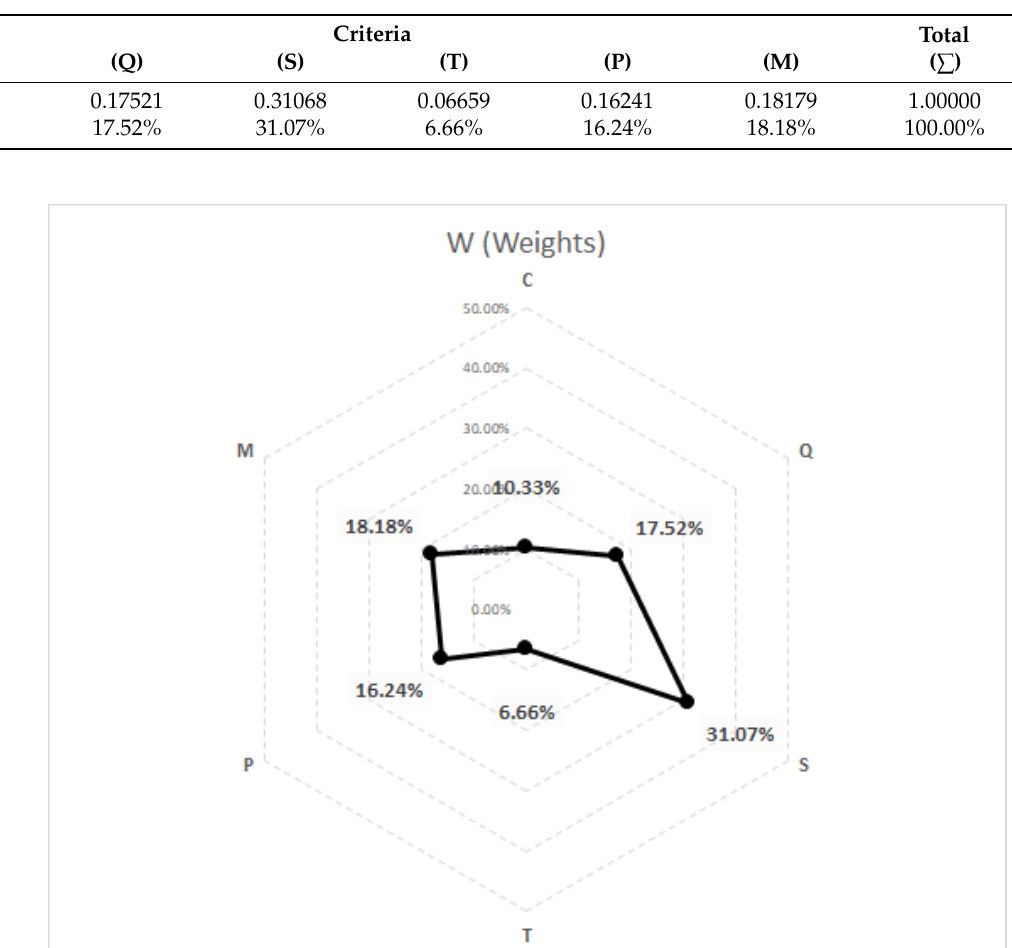
Table 18. Criteria weights from the aggregated matrix.